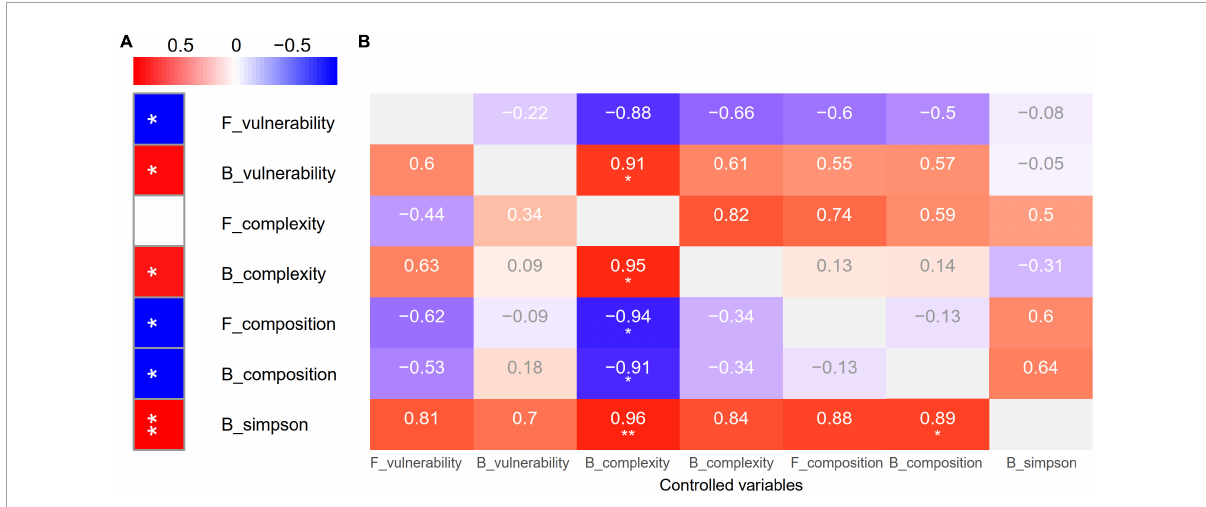
FIGURE5 Zero-order (A) and first-order (B) Pearson correlation analysis showing the relationships of biotic driving forces and soil multifunctionality. * p < 0.05, ** p <